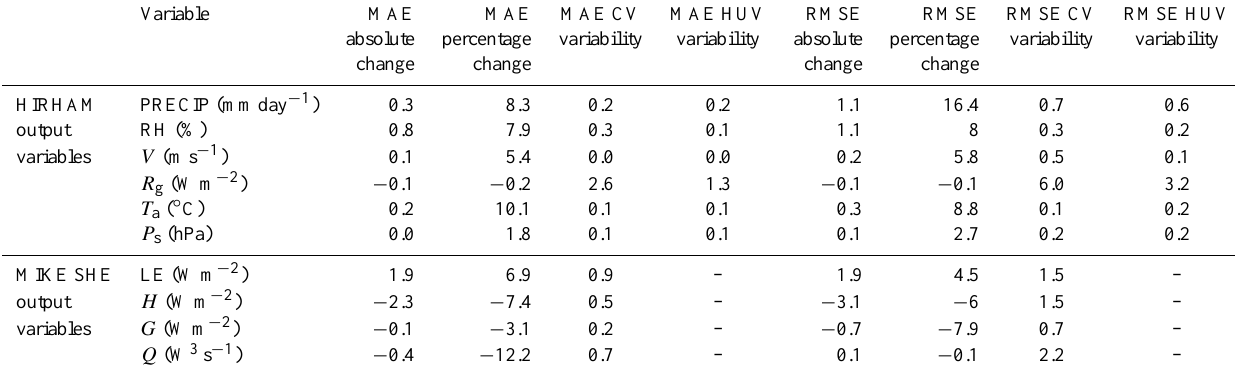
Table 2. Absolute and percentage change in MAE and RMSE between the largest (120min) and smallest (12min) DTI based on the average value of the linear trend lines of either the five test domains (HIRHAM output) or the measurement sites (MIKE SHE output). Also shown is the absolute variability from the CV and HUV runs defined as the minimum value subtracted from the maximum for the 60min DTI averaged between test domains (HIRHAM output) or measurement sites (MIKE SHE output) for each tested